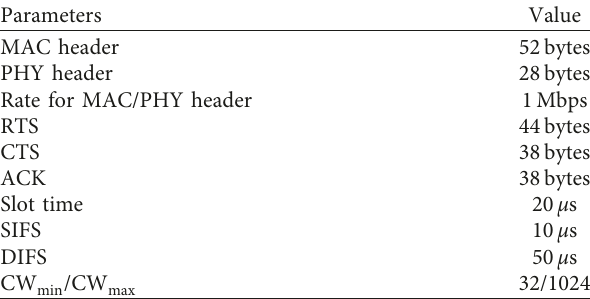
Table 1: Simulation parameters in the MAC layer.